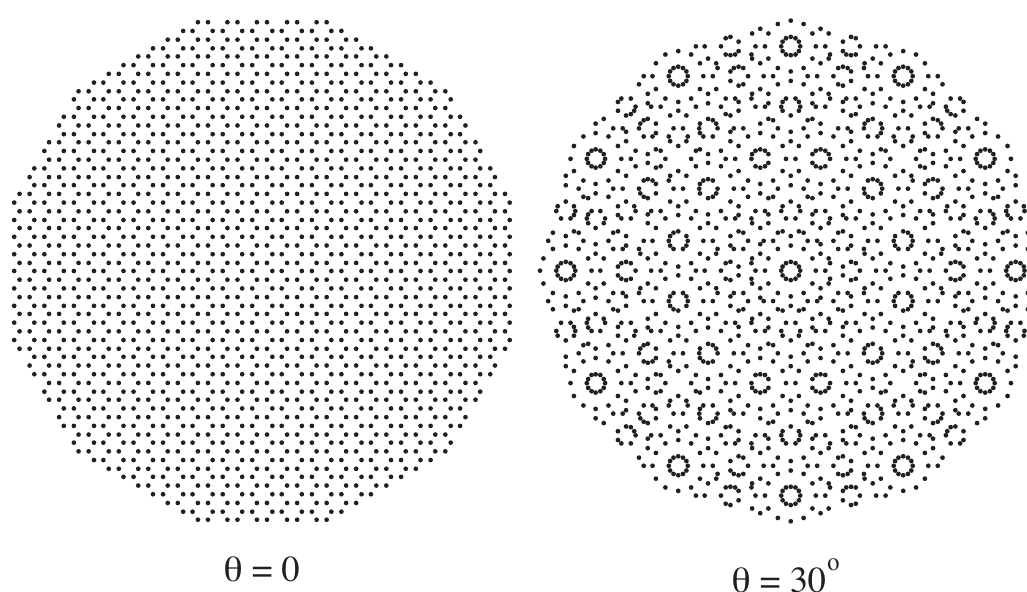
Figure 5. Projected structures (good fit lattices) obtained for θ = 0 and for two honeycombs rotated θ = 30 ◦ in between.